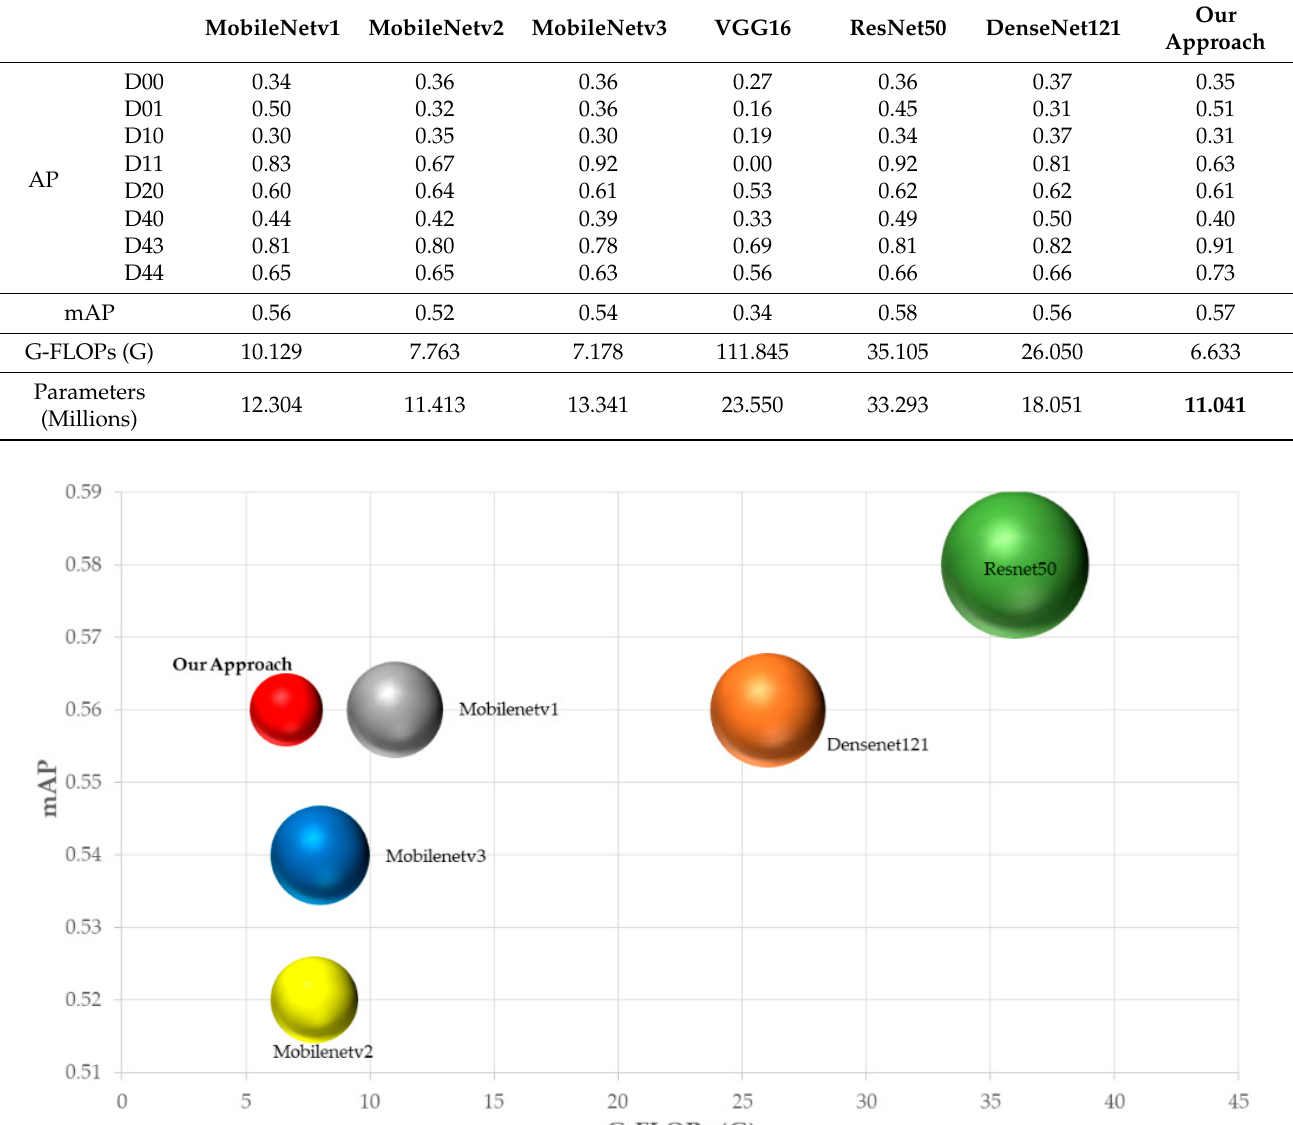
Table 10. The results of the ablation experiments using the attention module of the same dataset Backbone Feature Extraction Baseline Multi-scale feature fusion